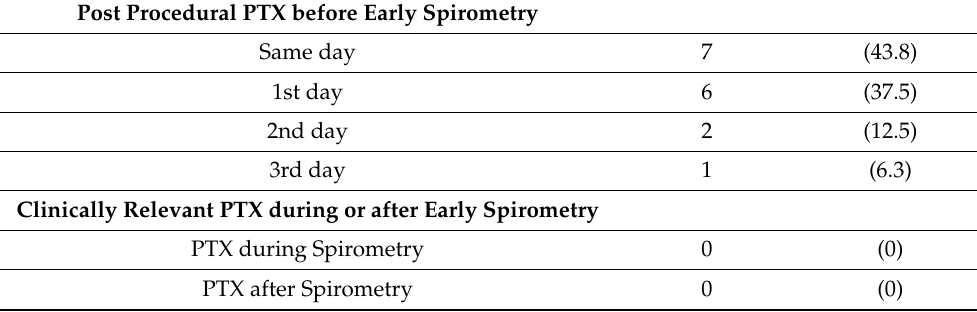
Table 2. Post-interventional pneumothorax ( n = 16).